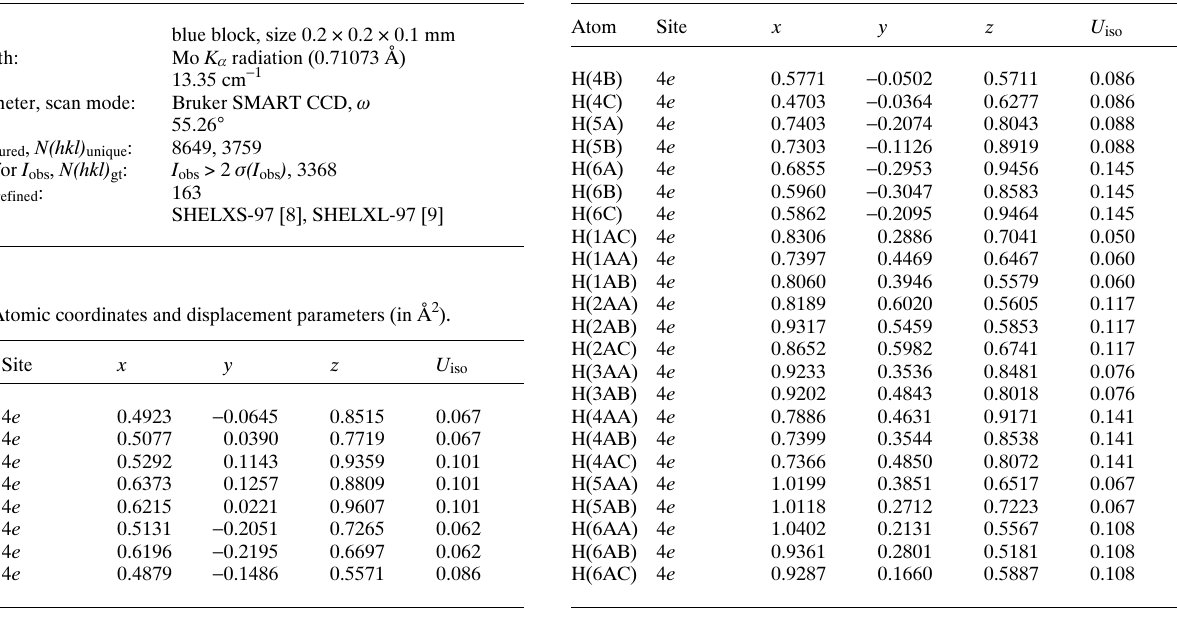
Table 1. Data collection and